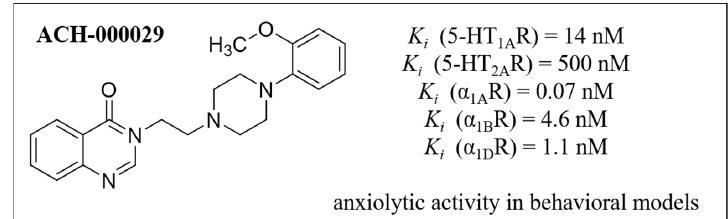
Figure 2. The chemical structure of ACH-000029 and its pharmacological profile.